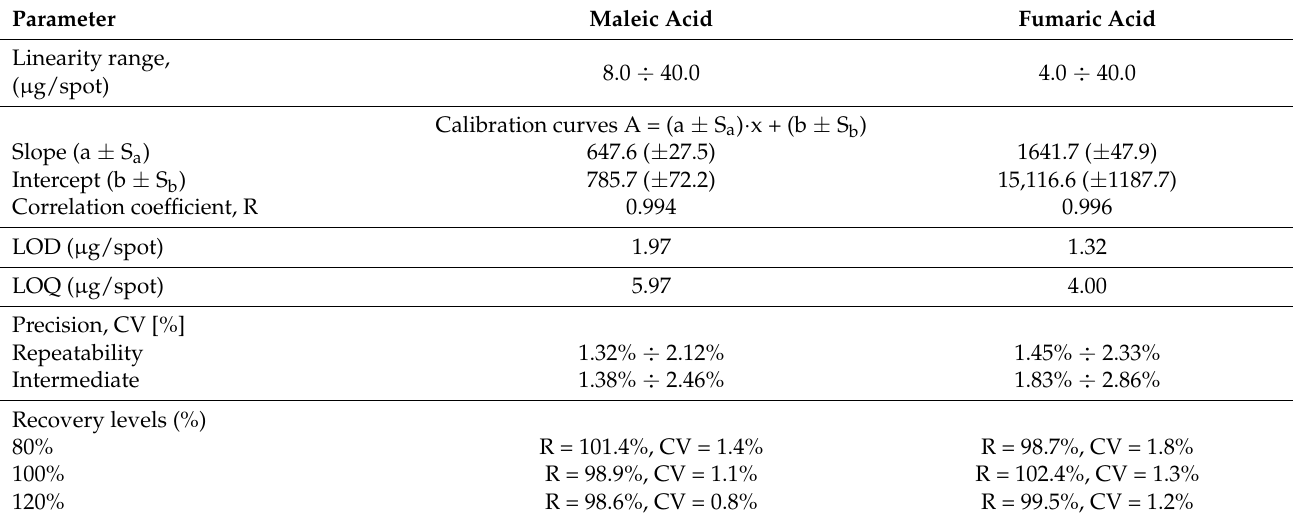
Table 2. NP-TLC method validation